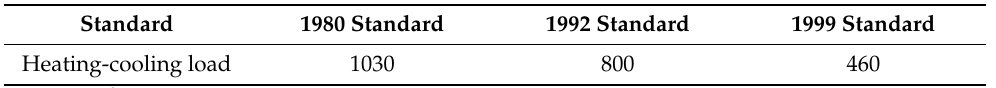
Table 1. Annual maximum allowable space conditioning (heating-cooling) loads for houses in moderate climate regions in Japan. Standard 1980 Standard 1999 Standard